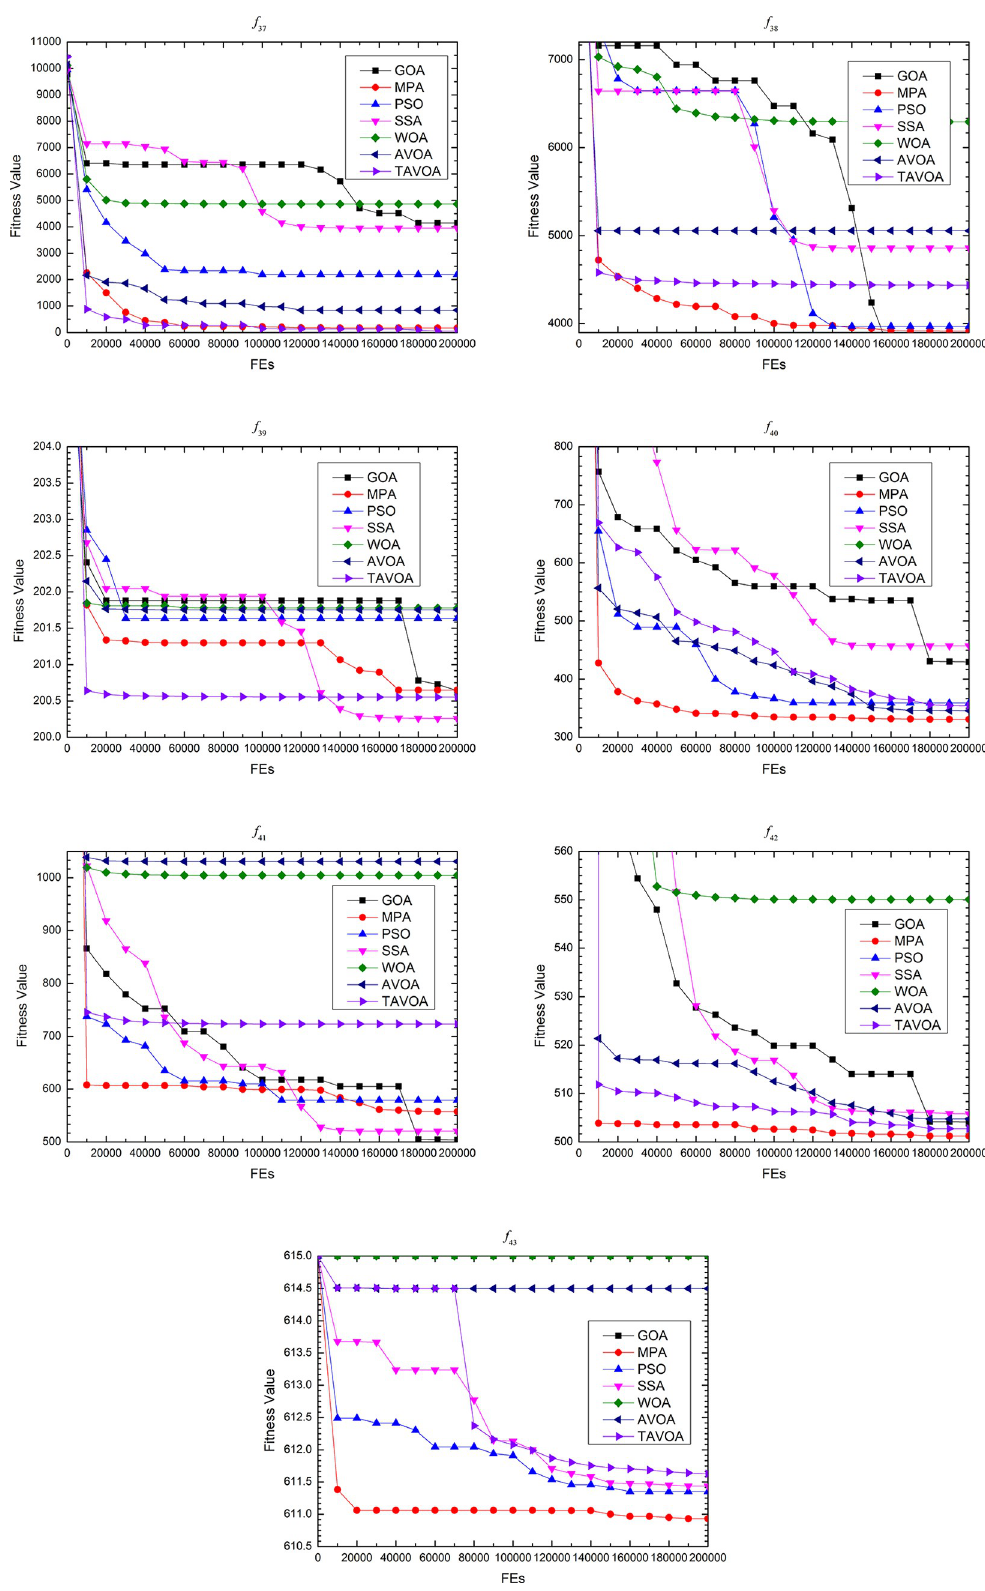
Fig 12. Convergence process on CEC 2013 multi-modal benchmark functions ( f 37 − f 43). https://doi.org/10.1371/journal.pone.0260725.g012 PLOS ONE | https://doi.org/10.1371/journal.pone.0260725 November30,